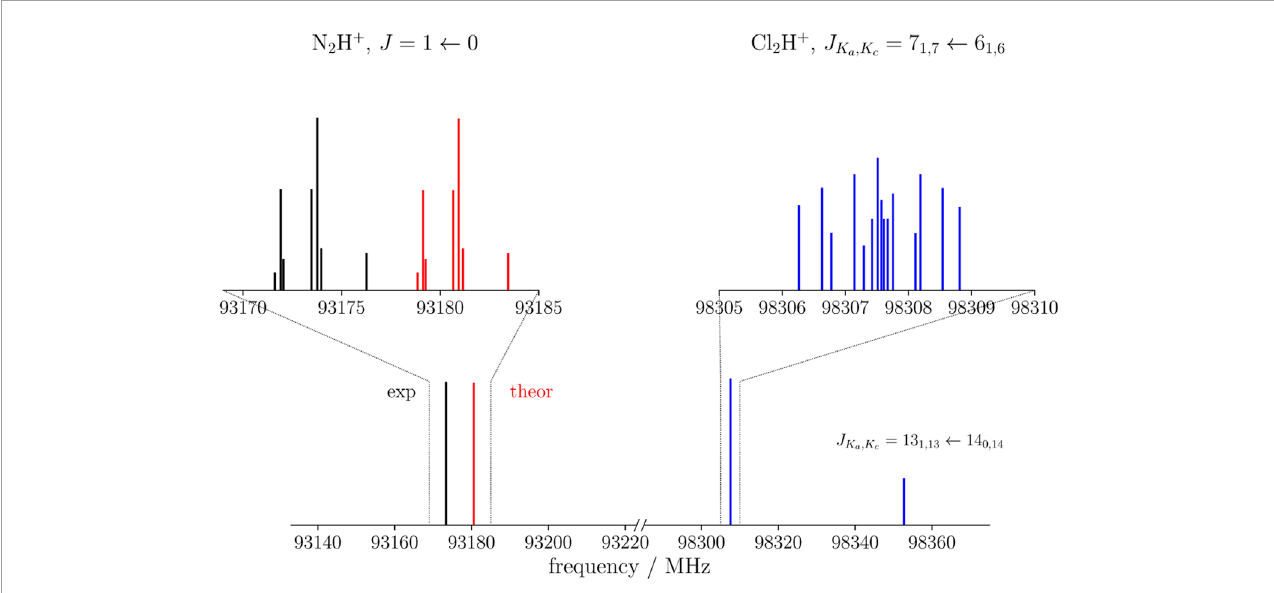
FIGURE 3 Theoretical (red) and experimental (black) J = 1 ← 0 transition of N 2 H + compared with the simulated spectrum of Cl 2 H + (blue) in the nearby frequency region. For the latter, both a -type ( J K